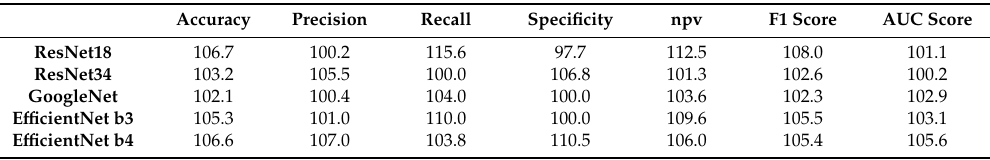
Table 4. Rate of change in predicted performance of ensemble model and image only by clinical variables {Ensemble model / hip radiographs alone